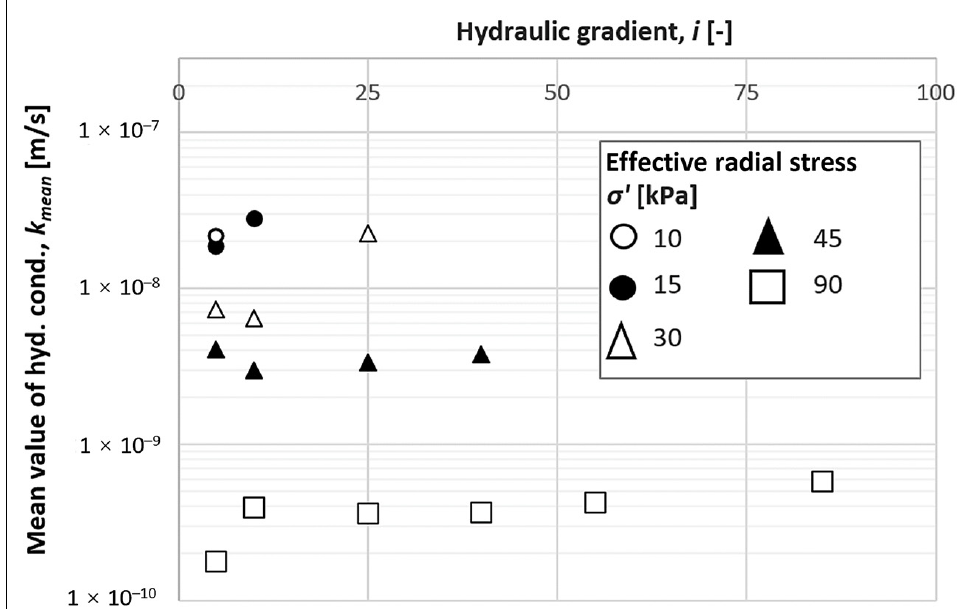
Figure 10. Relationship between average k values of peat from the Upper Biebrza Valley as a function of hydraulic gradient value for various values of effective radial stress (derived from triaxial tests).